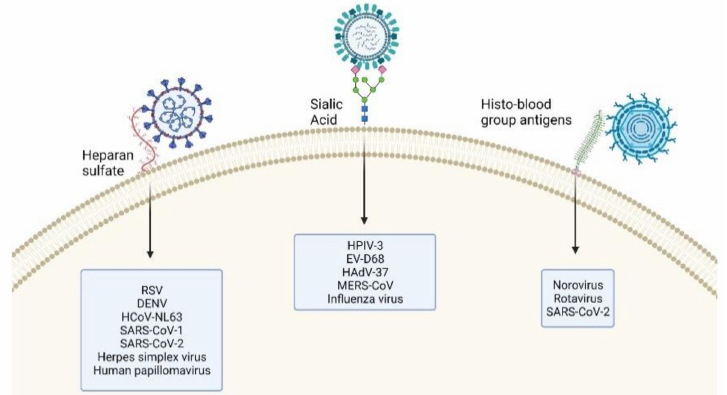
Figure 1. Glycosidic attachment receptor for viruses. Heparan sulfates, sialic acids and histo-blood group antigens are the main receptors used by the viruses to attach to the cell before infection. Examples of viruses binding to the different glycans are listed. Created with